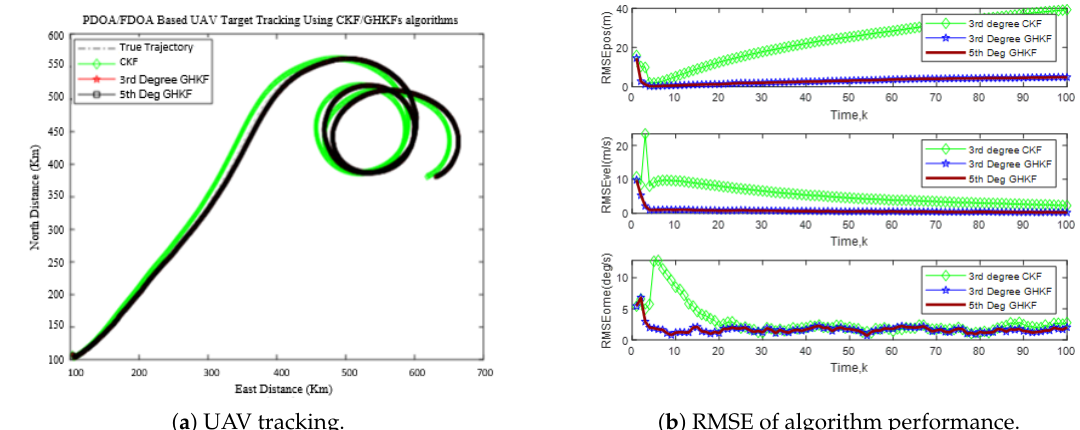
Figure 32. Target tracking and RMSE for verifying the algorithm performance. In the first simulation scenario, three (03) Iridium satellites were considered as sensors to estimate the trajectory and velocity of the UAV based on hybrid TDOA/PDOA measurements. Authors’ own